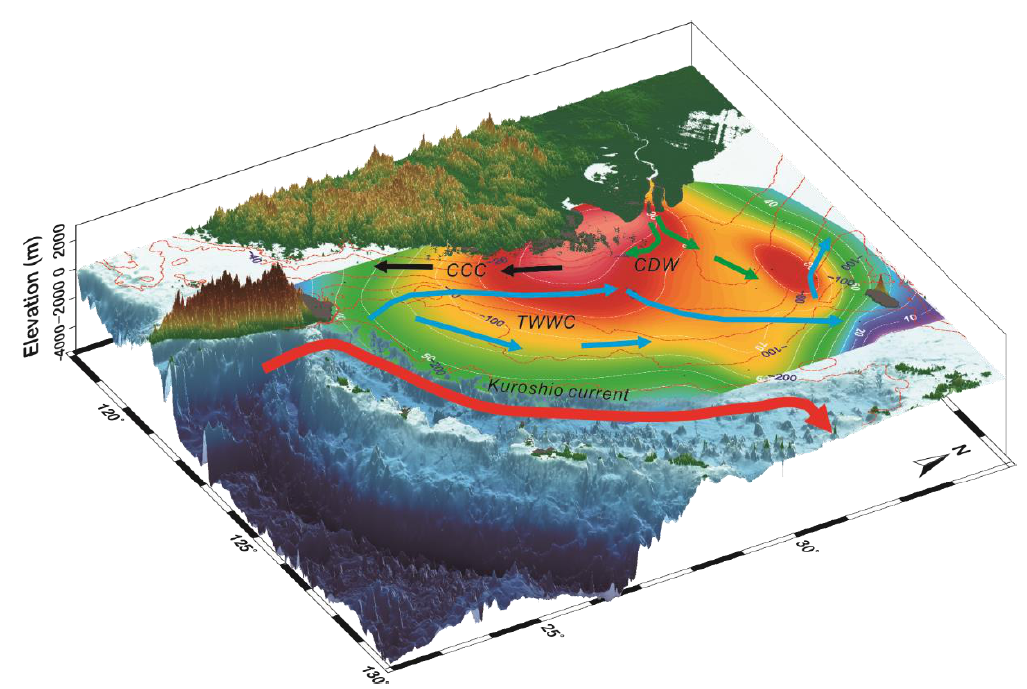
Figure 8. Spatial distribution of mixing coefficients of the Yangtze River in the East China Sea and the relationship with regional ocean currents. The color-filled area are contours of mixing coefficient of the Yangtze River while the red dashed denote the bathymetric contours. The arrows are ocean currents denoted in Figure 1.